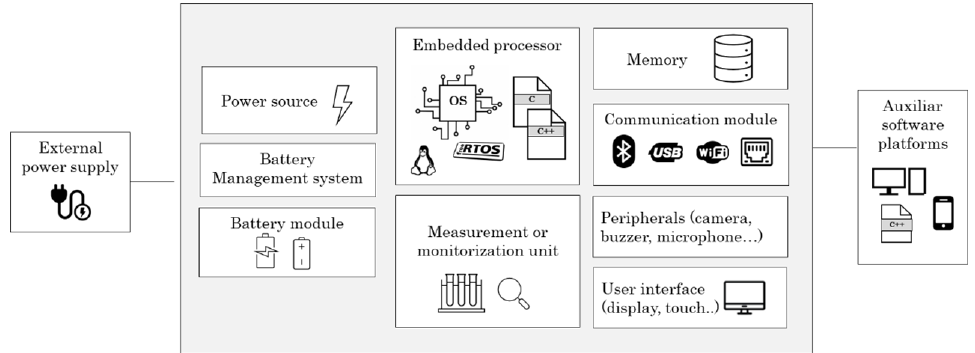
Figure 3. Typical embedded medical device block